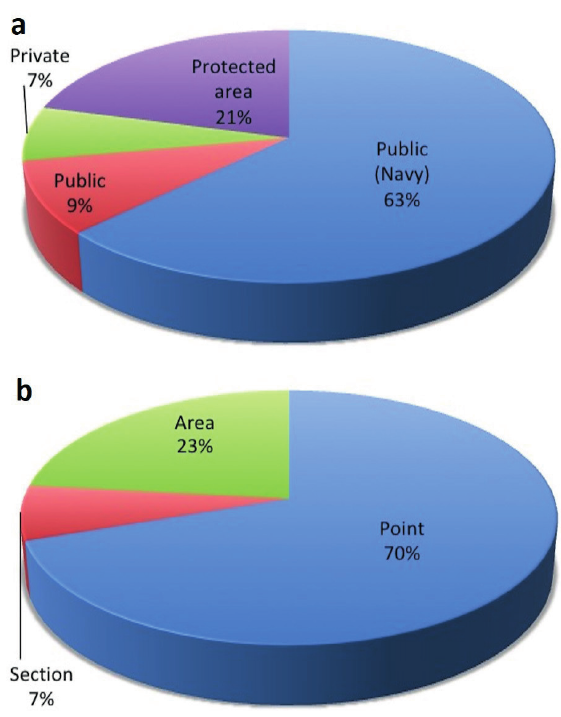
Figure 10 - Assessment of the geosites. a ) relative magnitude of the geosites in relation to the ownership regime; b ) relative magnitude of the geosites in relation to typology in the sense of Fuertes-Gutiérrez and Fernández-Martínez